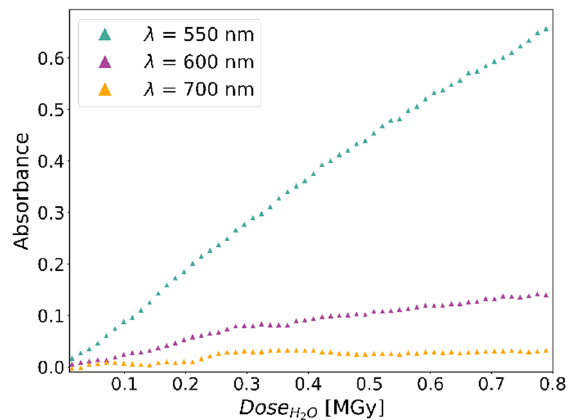
Figure 8. Absorbance as a function of the dose for the dosimeter with a B3 Risø film for the dose measurement of the radiation field from a 1.02 MeV energy electron beam. λ denotes the wavelength.